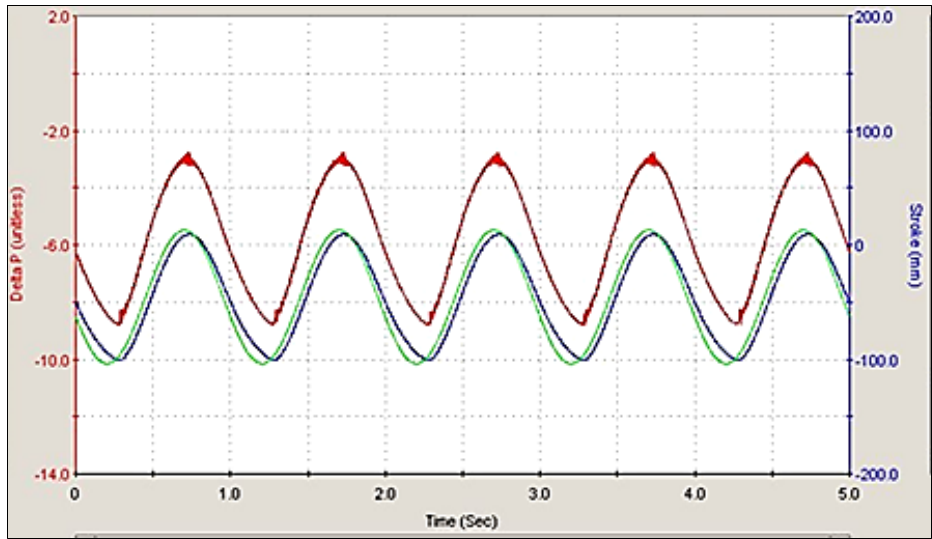
Figure 5. Experiment results